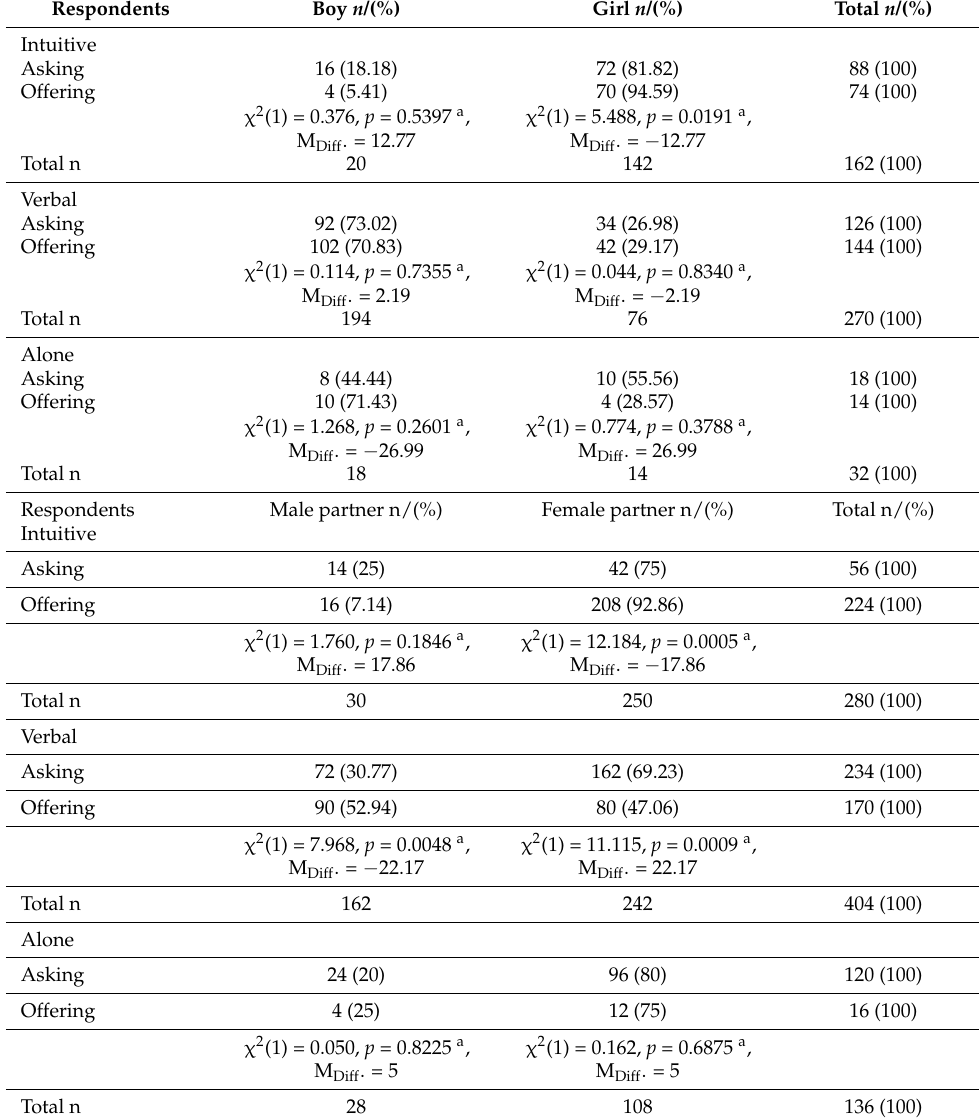
Table 7. Comparisons of offering and asking for help situations between males and females, in intuitive or verbal